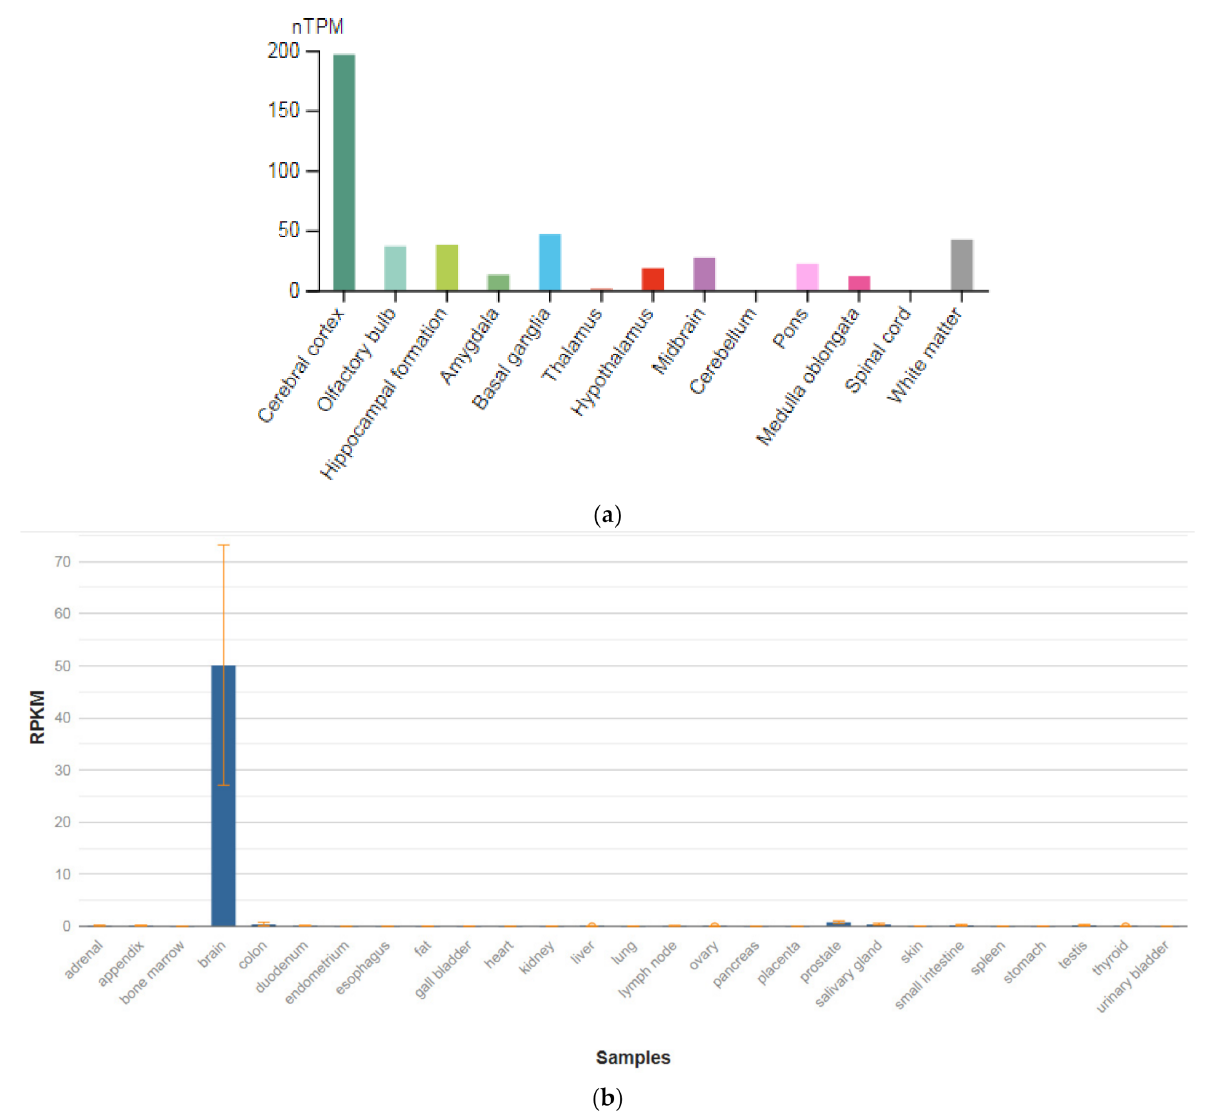
Figure 2. The tissue expression of the glutamate ionotropic receptor NMDA type subunit 1 in the brain ( a ) and other organs in the human body ( b